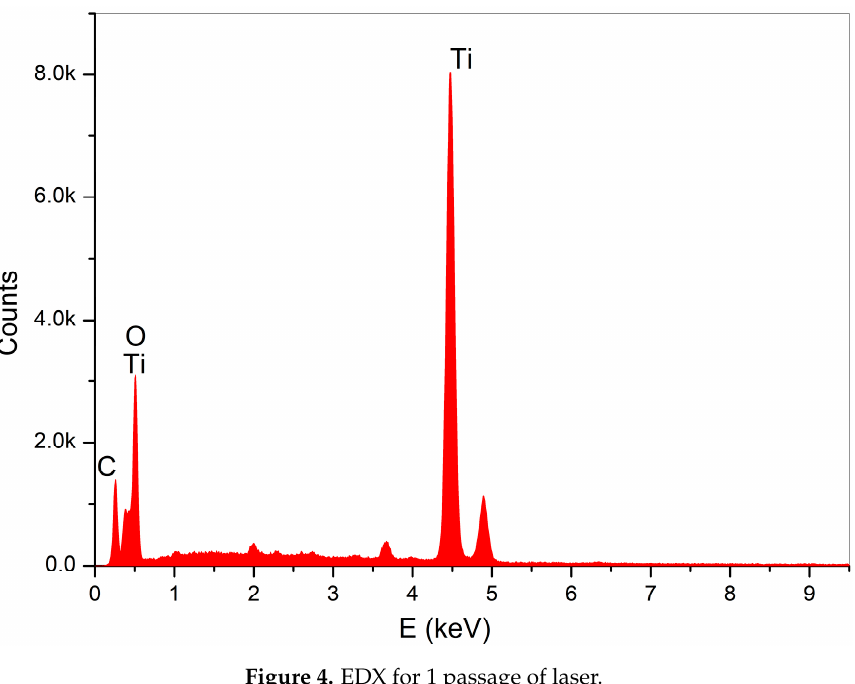
Figure 4. EDX for 1 passage of laser.